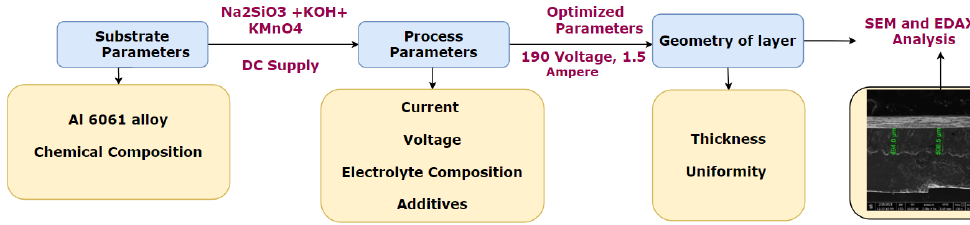
Figure 2: Optimized parameters obtained from experiments.